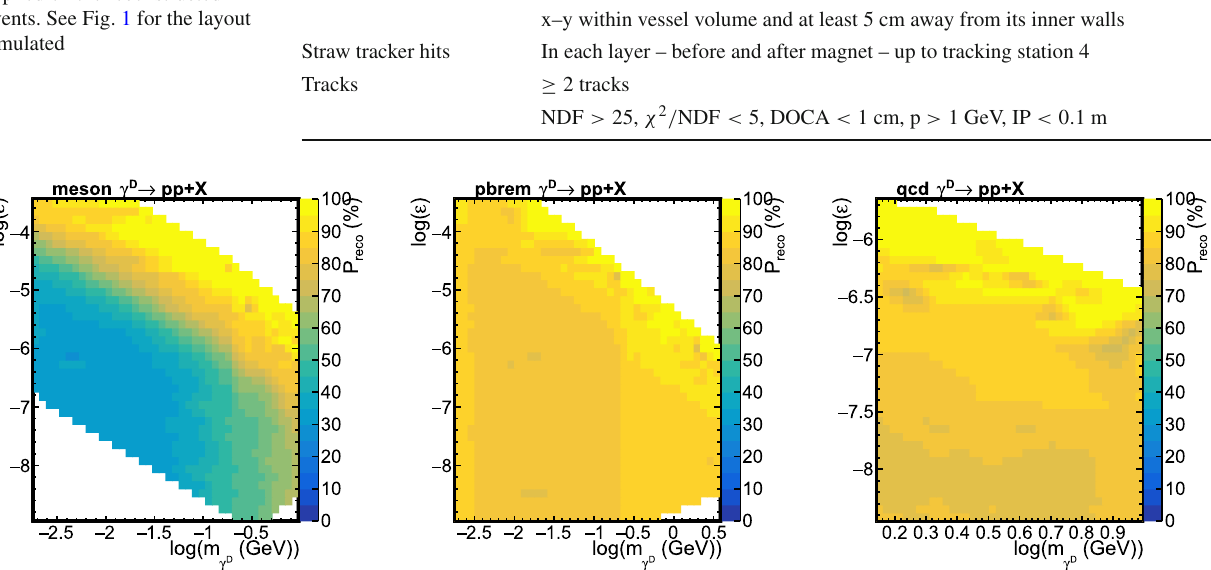
1 . 7 ± 0 . 7. The total systematic uncertainty is hence taken as ±